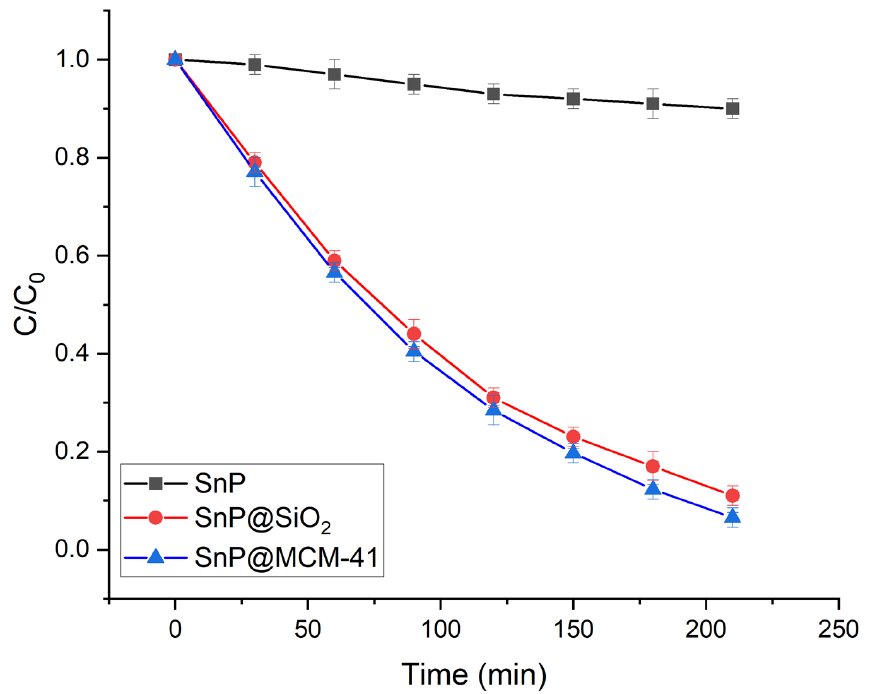
Figure 8. Photocatalytic degradation of the RhB dye in an aqueous solution (pH = 7, T = 298 K) under visible light irradiation.